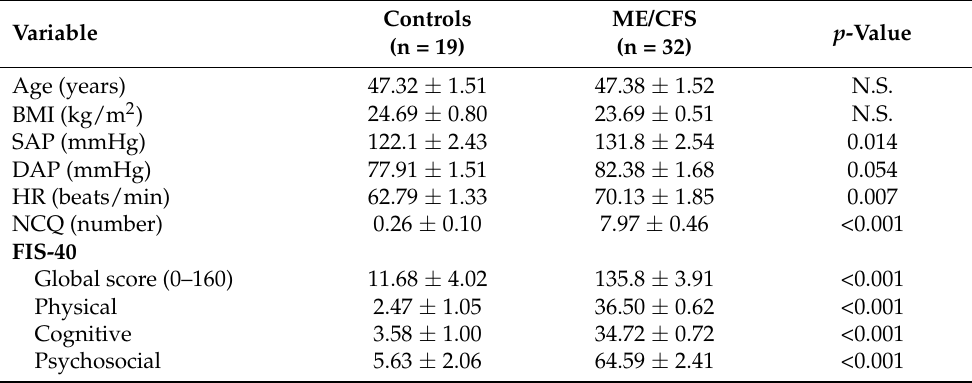
Table 1. Baseline demographic and clinical parameters among participants